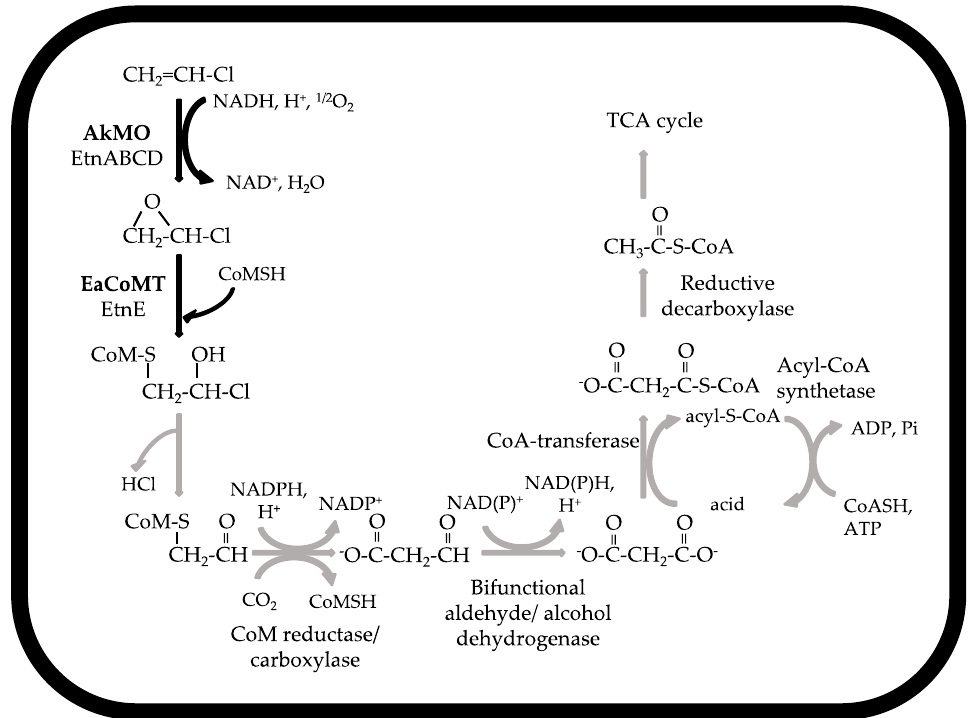
Figure 4. Aerobic oxidation pathway of VC and ethene. Grey arrows: hypothetical reactions (modified from [65]).